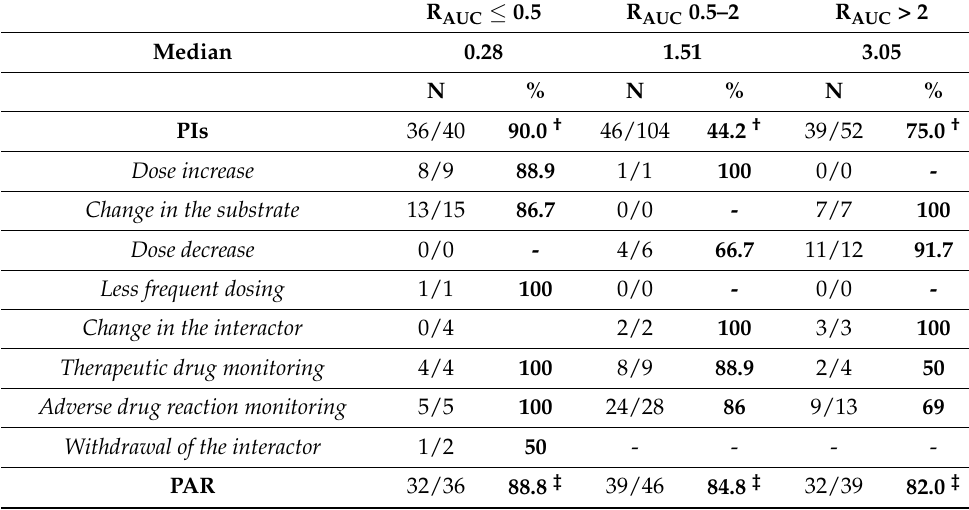
Table 2. Description of the type of PI and the PAR. † p < 0.0001; ‡ p < 0.729.